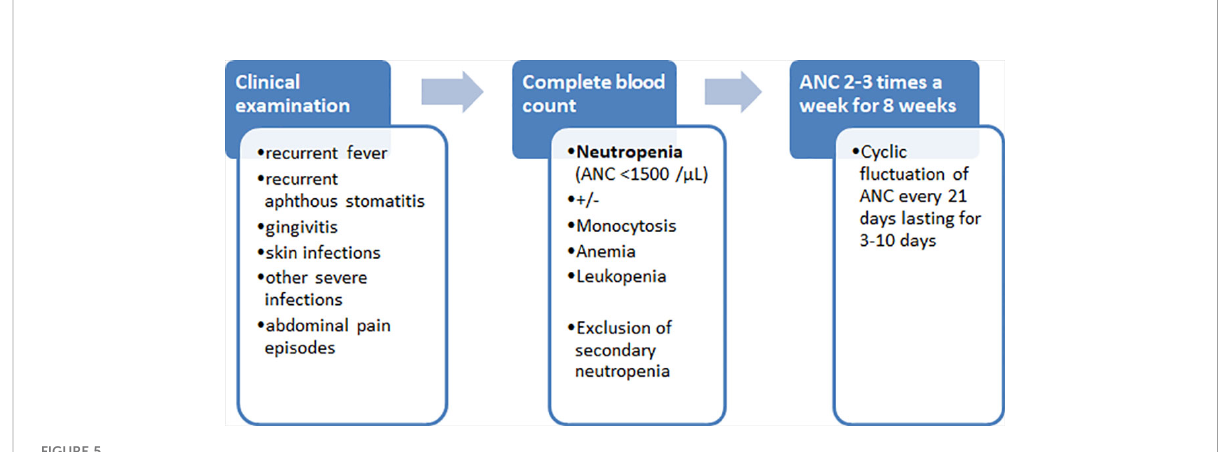
FIGURE 5 Diagnostic algorithm of cyclic